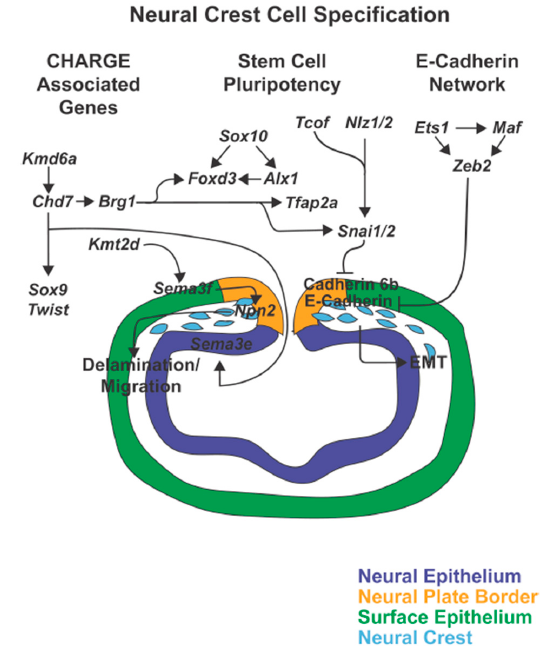
Figure 3. Neural crest cell specification. As the neural tube closes, genes including Sox10 , Foxd3 , Alx1 , Tfap2a, Tcof , Nlz1 / 2 , and Snai1 / 2 induce neural crest cell identity and maintain stem cell pluripotency. Simultaneously, Tcof , Nlz1 / 2 , and Sna1 / 2 , together with Ets1 , Maf , and Zeb2 inhibit E-Cadherin and Cadherin 6b within the premigratory neural crest to trigger epithelial-mesenchymal transition (EMT). Furthermore, the CHARGE associated genes, Chd7 , Kmd6a , Brg1, and Kmt2d regulate neural crest cell delamination and initiation of